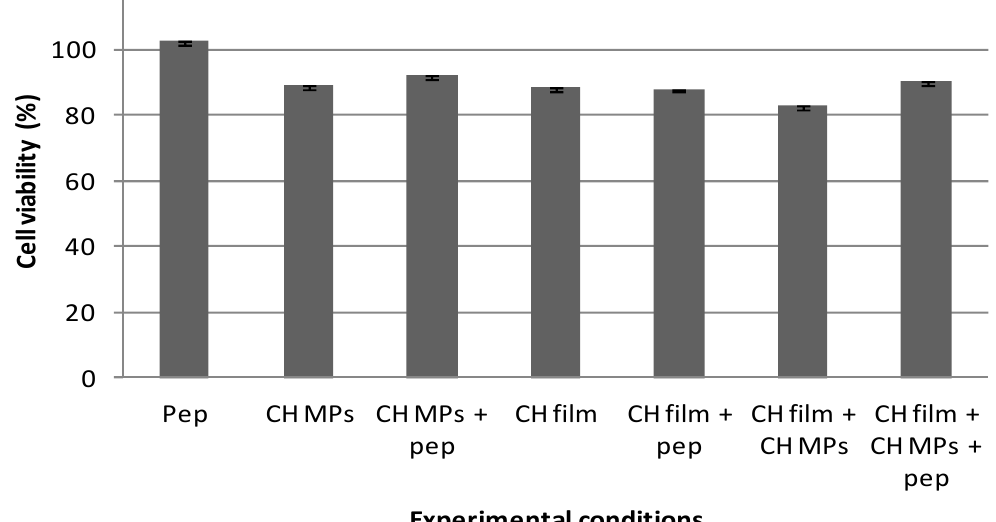
Figure 3. Cell viability under effect of peptide (5 µ g/mL); CH MPs, CH film and CH MPs incorporated into CH film with and without peptide (5 µ g/mL), measured by MTT assay and expressed as the mean ± SD ( n = 5).